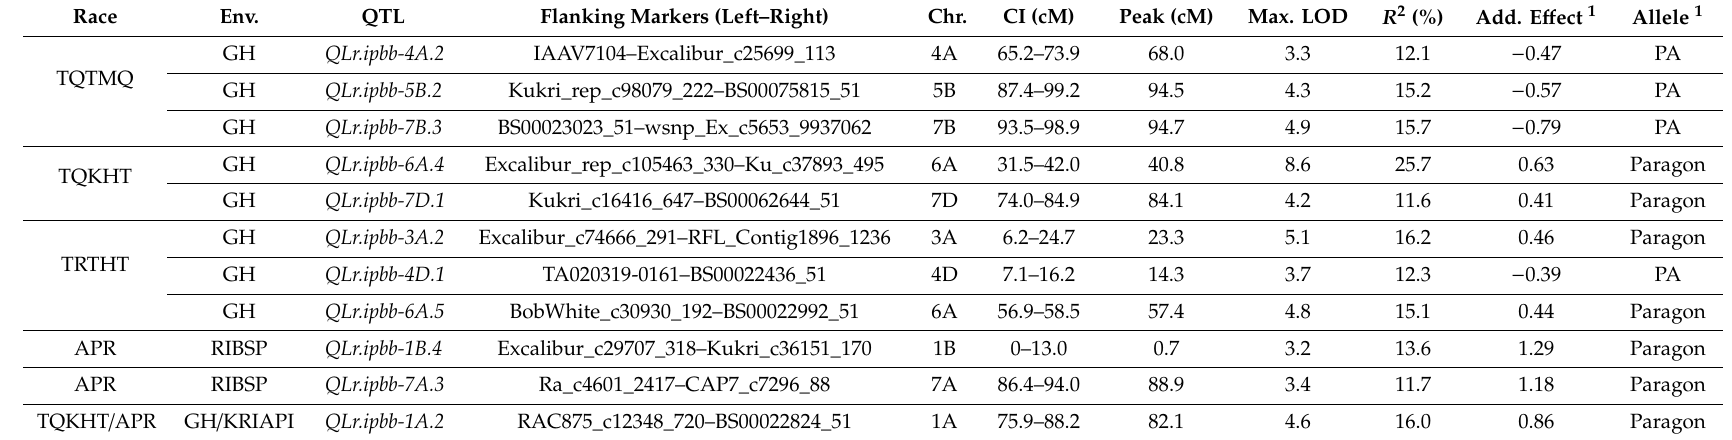
Table 7. The list of quantitative trait loci (QTLs) for adult plant resistance (APR) and race-specific seedling resistance to leaf rust (LR) identified in the Pamyati Azieva × Paragon recombinant inbred lines (RILs)